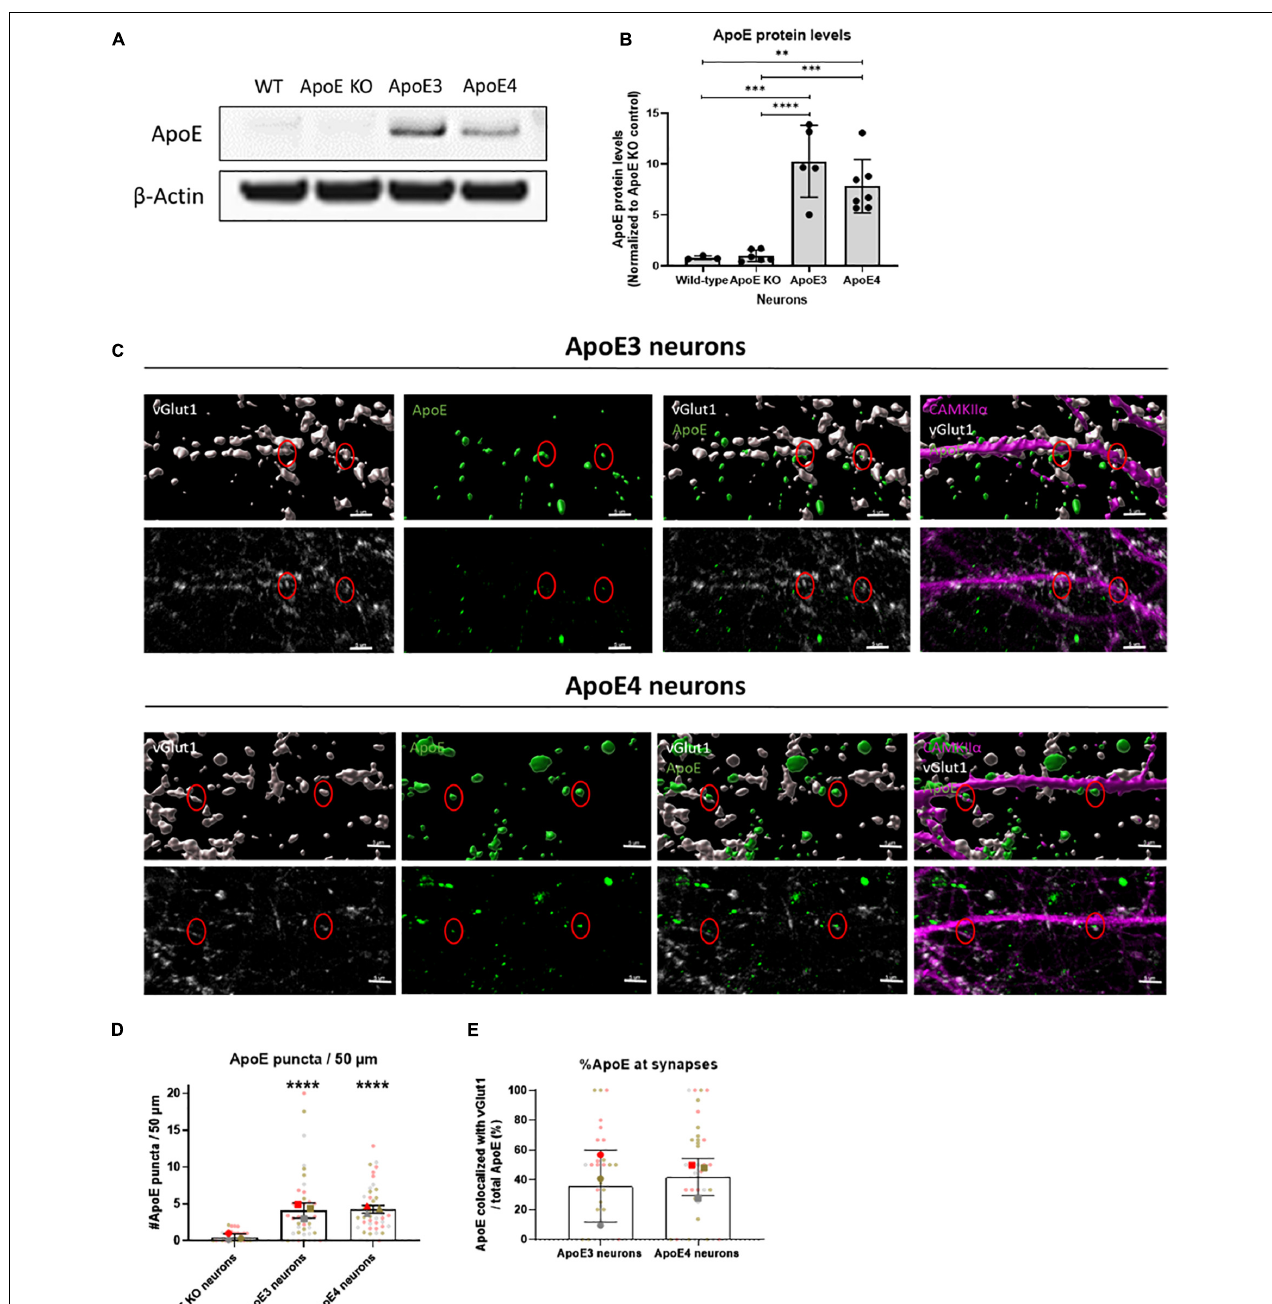
FIGURE 3 | Endogenously expressed human ApoE in neurons can be detected at synaptic terminals. (A) Representative Western blot analysis of human ApoE protein levels in lysate of wild-type (WT), ApoE KO, ApoE3 KI and ApoE4 KI primary mouse neurons (15 DIV). β -Actin was used as a loading control. (B) Quantification of ApoE protein levels in WT, ApoE KO, ApoE3 KI and ApoE4 KI neuronal lysate detected by Western blot analysis ( N wild − type = 3 embryos, N ApoEKO = 6 embryos, N ApoE 3 = 5 embryos, N ApoE 4 = 7 embryos). The data was normalized to ApoE protein levels in ApoE KO neurons (ApoE KO = 1). (C) Representative 3D Imaris reconstructed (upper panels) and non-reconstructed confocal images (lower panels) of ApoE (green), presynaptic marker vGlut1 (gray), and excitatory neuronal marker CAMKII α (magenta) labeling in ApoE3 and ApoE4 primary neurons (19 DIV). Red circles indicate ApoE and vGlut1 co-localization. Scale bar is 5 µ m. (D,E) Quantification of confocal microscopy shown in 3C of ApoE puncta in neurites per 50 µ m ( N = 3 embryos, n = 42 neurites per condition) (D) and percentages of ApoE puncta co-localizing to vGlut1-positive synaptic terminals ( N = 3 embryos; neurites expressing ApoE are used in our co-localization analysis only, n ApoE 3 = 33 neurites, n ApoE 4 = 39 neurites) (E) . In panel (D) , significance levels compared to ApoE KO neurons are indicated in the graph. Statistical differences were assessed using Kruskal Wallis test, followed by Dunn’s test for multiple comparisons (D) or Mann Whitney test (E) . Data are shown in superplots and are expressed as mean ± SD. ** p < 0.01; *** p < 0.001; **** p <